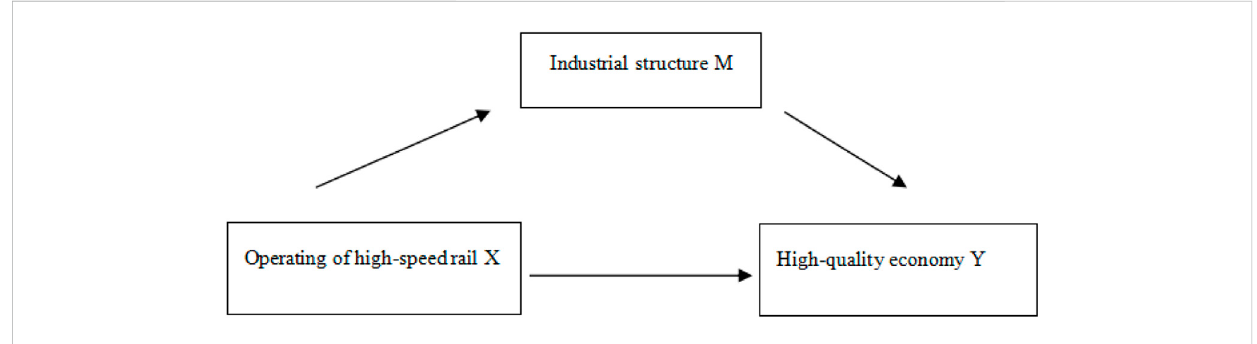
FIGURE 1 Logical diagram of mediation